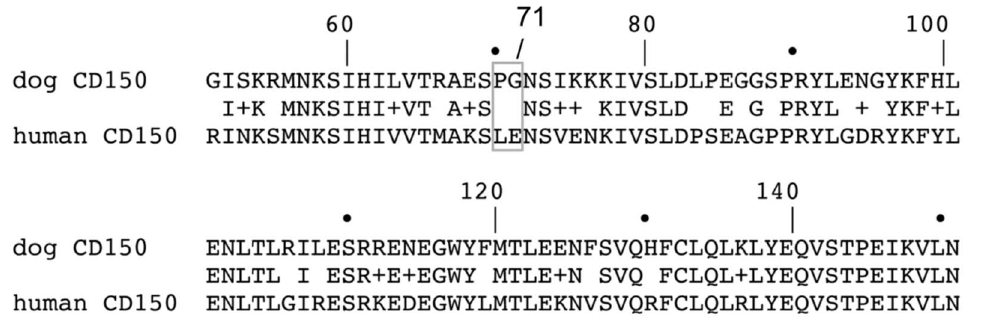
Figure 8. Comparison of the canine and human CD150 sequences around the Morbillivirus H binding site. The MV-H binding site of CD150 was mapped between amino acid 61 and 131 [33]. Amino acid 71 is an uncharged G in dog CD150, and a negatively charged E in human CD150 (NM_001003084 [25]).